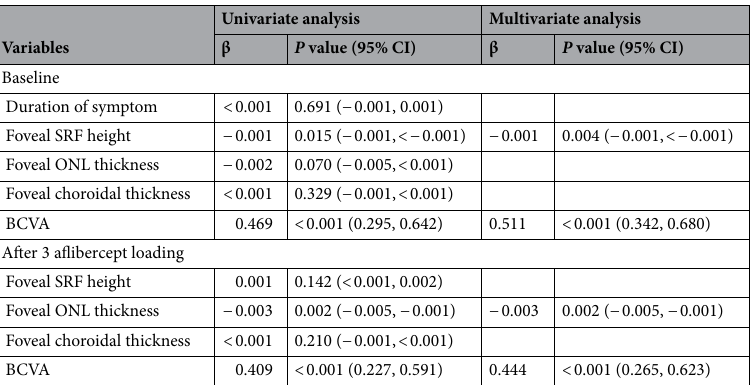
Table 2. Linear regression analysis of biomarkers in relation to the BCVA at 1-year follow-up. SRF subretinal fluid, ONL outer nuclear layer, BCVA best corrected visual acuity, β regression coefficient, CI confidence